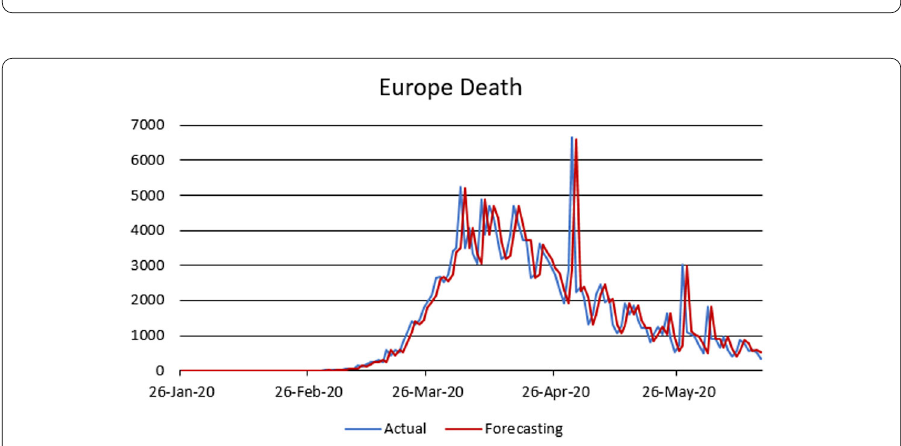
Figure 10 Exponential smoothing for deaths in Europe